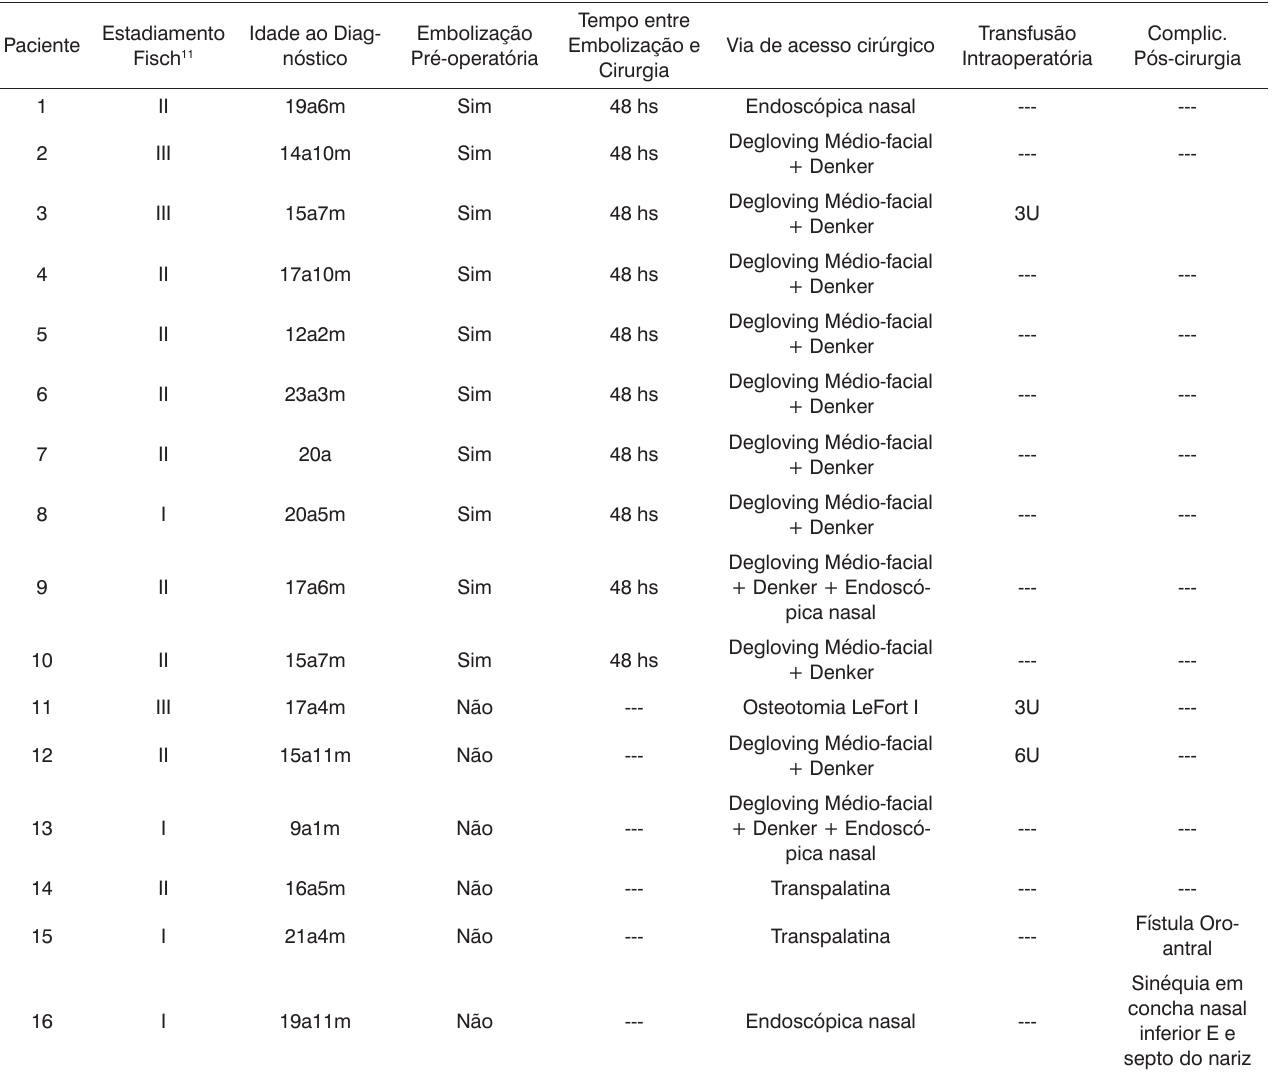
Tabela 1. Dados dos pacientes em relação à idade ao diagnóstico, necessidade de embolização, via de acesso para tratamento e complica- ções